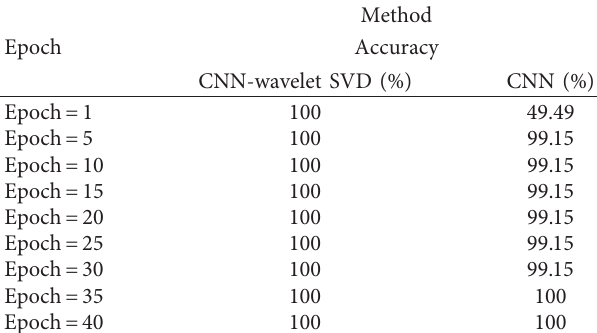
Figure 10: Accuracy of the CNN (partial magnification). Table 2: Recognition rate of CNN-wavelet SVD and CNN.